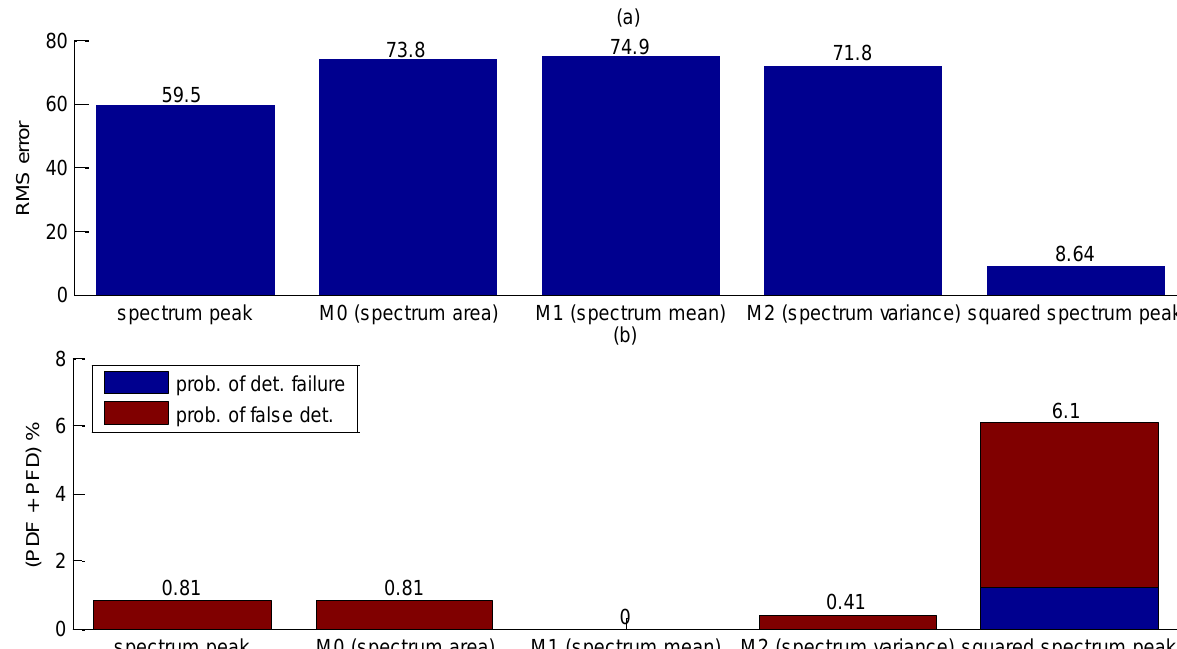
Figure 15. Accuracy results of interfacial detection with transducer obstructed by a metallic plate. ( a ) RMS error results. ( b ) Probability of false detection and detection failure results.